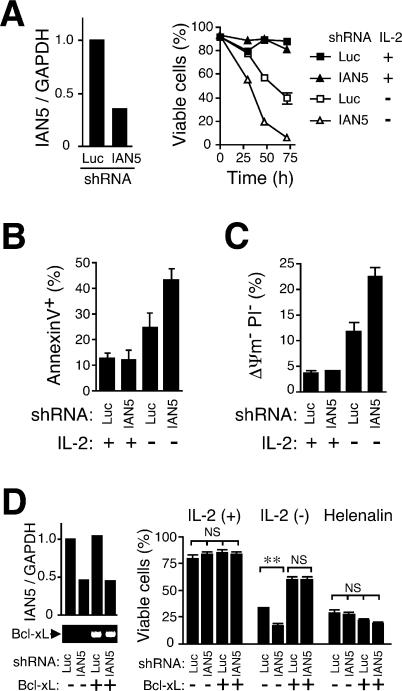
Knockdown of IAN5 in 23–1–8 T Lymphocytes(A) 23–1–8 T lymphocyte clones expressing shRNAs were analyzed for
IAN5 mRNA expression and cultured in the presence or absence of IL-2. Cell viability was quantified by PI staining and flow cytometry analysis.
(B and C) Cells in 48-h culture were analyzed for apoptosis induction. Frequencies of Annexin-V-positive cells (B) or mitochondrial membrane potential (Δψm)-negative cells (C) are shown.(D) 23–1–8 T cells expressing shRNAs with or without human
Bcl-xL were analyzed for
IAN5 expression by quantitative RT-PCR and for human
Bcl-xL expression by conventional RT-PCR (left panel). Cells were cultured in the presence or absence of IL-2 for 72 h or in the presence of IL-2 and 5 μM helenalin for 48 h, and cell viability was quantified by PI staining (right panel).
Graphs show means ± standard errors.NS, not significant (
p ≥ 0.05);
**
p < 0.01.